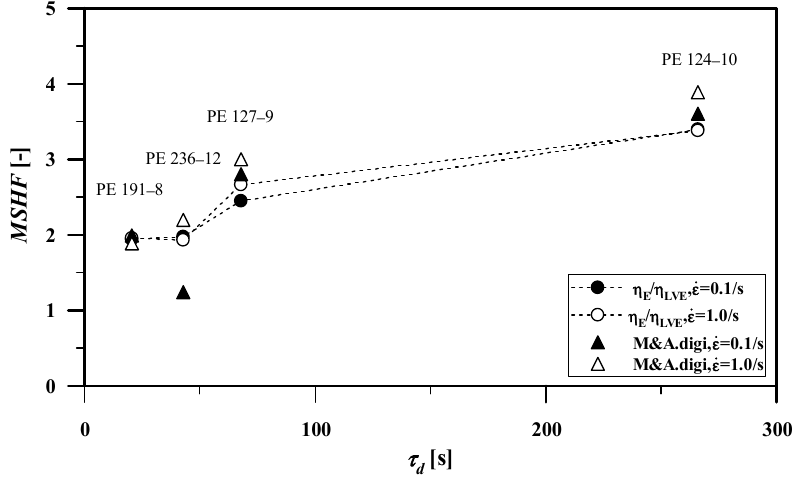
Figure 9. Comparison between the MSHF values of MA [23] (triangle, Equation (9)) and those generated by the HMMSF model (circle, Equation (11)).